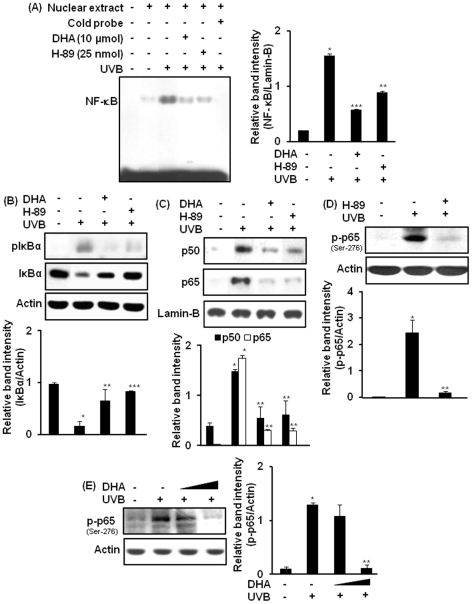
Inhibitory effect of DHA on UVB-induced activation of NF-κB is mediated through inhibition of MSK1.Mice (n = 3 per treatment group) were treated topically with H-89 (25 nmol) or DHA (10 µmol) as described in figure 2 and sacrificed 1.5 h later. (A) Nuclear protein (10 µg) was subjected to EMSA to examine the effect of H-89 or DHA on UVB-induced DNA binding of NF-κB. *,
p<0.001 (control versus UVB); **,
p<0.01 (UVB versus 10 µmol DHA plus UVB); ***,
p<0.001 (UVB versus 25 nmol H-89 plus UVB). (B) Inhibitory effects of H-89 or DHA on UVB-induced phosphorylation of IκBα was measured by immunoblot analysis. *,
p<0.001 (control versus UVB); **,
p<0.01 (UVB versus 10 µmol DHA plus UVB); ***,
p<0.001 (UVB versus 25 nmol H-89 plus UVB). (C) Nuclear extracts were analyzed by western blotting for nuclear translocation of p50 and p65. *,
p<0.001 (control versus UVB); **,
p<0.01 (UVB versus 10 µmol DHA or 25 nmol H-89 plus UVB). (D) Dorsal skin of HR-1 hairless mice was treated topically with H-89 (25 nmol/mouse) followed by irradiation with UVB to detect the phosphorylation of NF-κB p65 (serine-276). *,
p<0.001 (control versus UVB); **,
p<0.001 (UVB versus 25 nmol H-89 plus UVB). (E) Epidermal lysates from mice pretreated with DHA (2.5 or 10 µmol/mouse) and irradiated with UVB were subjected to western blotting analysis to determine the phosphorylation of NF-κB p65 (serine-276). *,
p<0.001 (control versus UVB); **,
p<0.001 (UVB versus 10 µmol DHA plus UVB). Figure S2, represents the effect of H-89 on UVB-induced phosphorylation of IKKα/β (Ser 181).